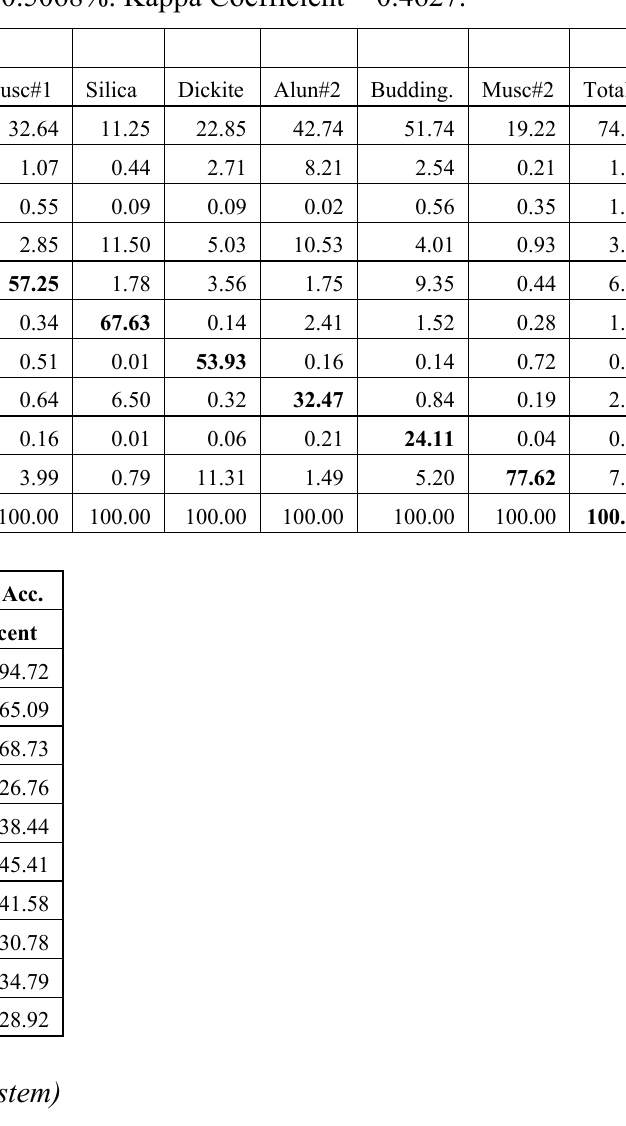
Table 1. Confusion matrix for Cuprite, Nevada, 15 m versus 60 m HyspIRI